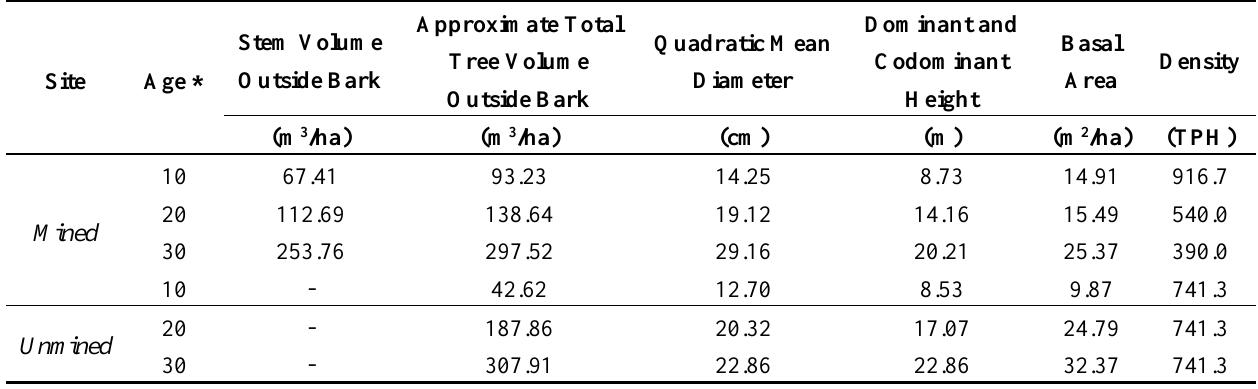
Table 5. Stand level data for loblolly pine plantations on reclaimed mineland in east Texas and unmined sites across east Texas from the East Texas Pine Plantation Research